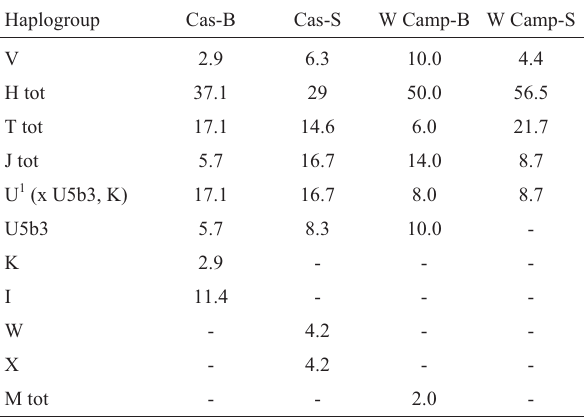
Table 2 - MtDNA haplogroup distribution obtained using the two sam- pling methods (values are expressed as relative distribution